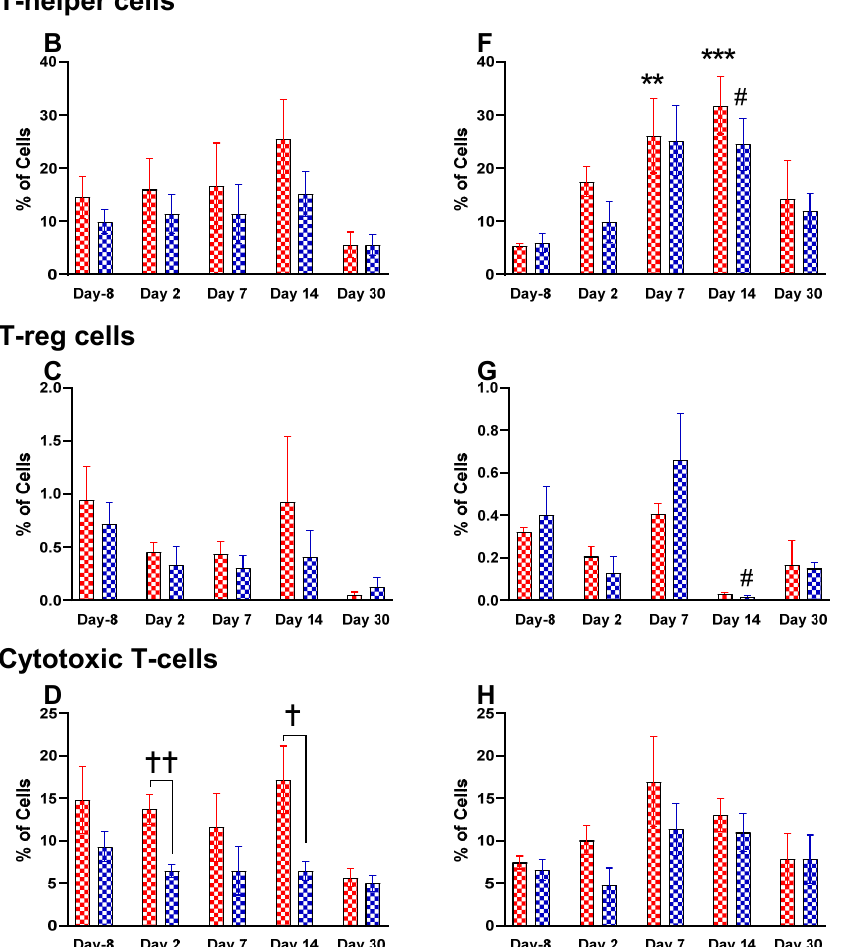
Figure 7. Effects of 4 and 5.8 Gy on T-cell ( A , E ), T-helper cell ( B , F ), T-reg cell ( C , G ), and cytotoxic T-cell ( D , H ) expression in BM of NHPs. NHPs received GT3 (37.5 mg/kg) or vehicle 24 h prior to irradiation (4 and 5.8 Gy). BM was collected at various time points, and the expression of T + cells and their subsets were analyzed. Data are expressed as mean ± SEM. * p < 0.05, ** p < 0.01, *** p < 0.001 vs. vehicle day-8; # p < 0.05 vs. GT3 day-8; † p < 0.05, †† p < 0.01, vehicle vs. GT3 at Day 2 and 14.